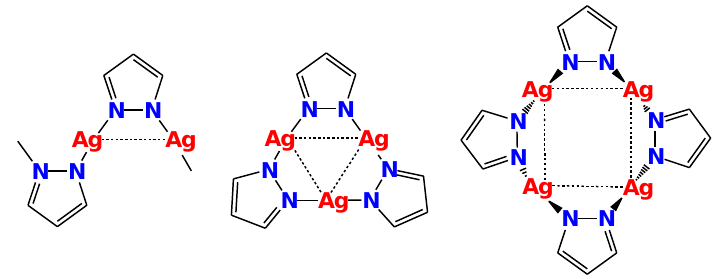
Figure 1. Schematic drawing of silver(I) pyrazolato complexes; left: polynuclear, center: trinuclear, right: tetranuclear. Dotted lines show intramolecular Ag···Ag interactions.